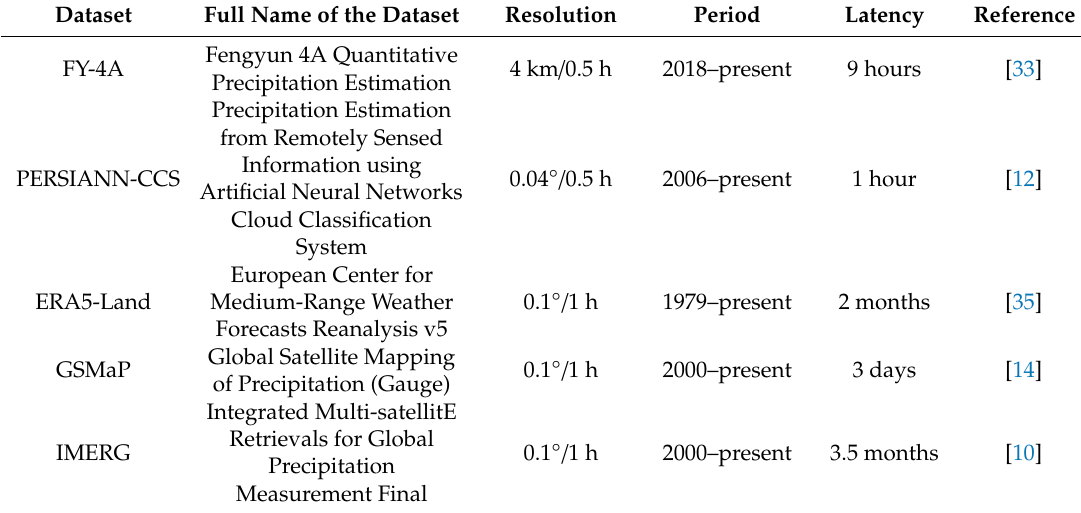
Table 1. Summary of the satellite and reanalysis datasets used in this